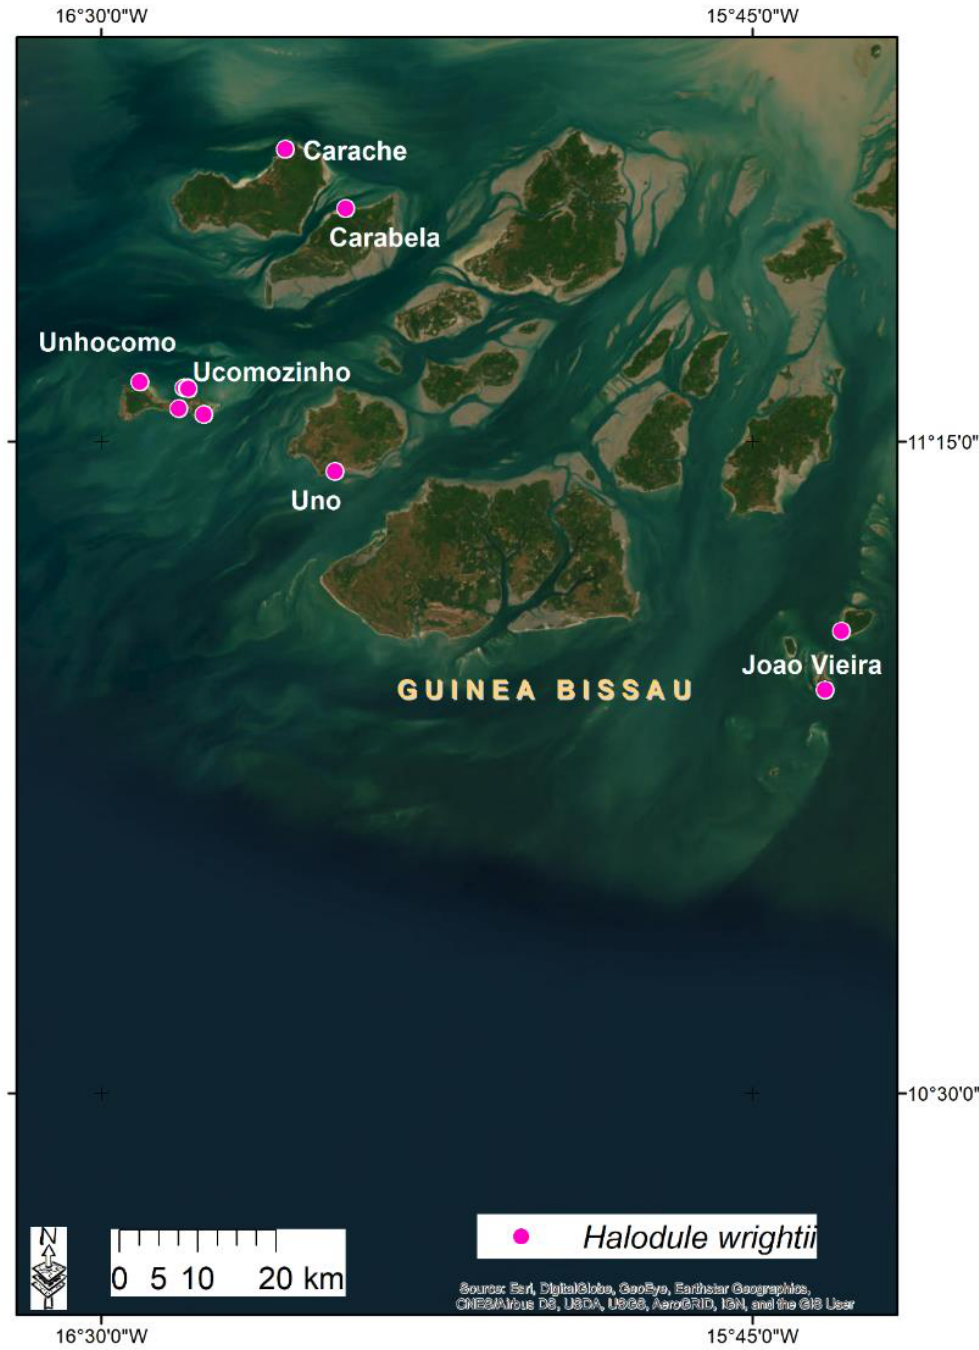
Figure 6. Seagrass distribution in Guinea